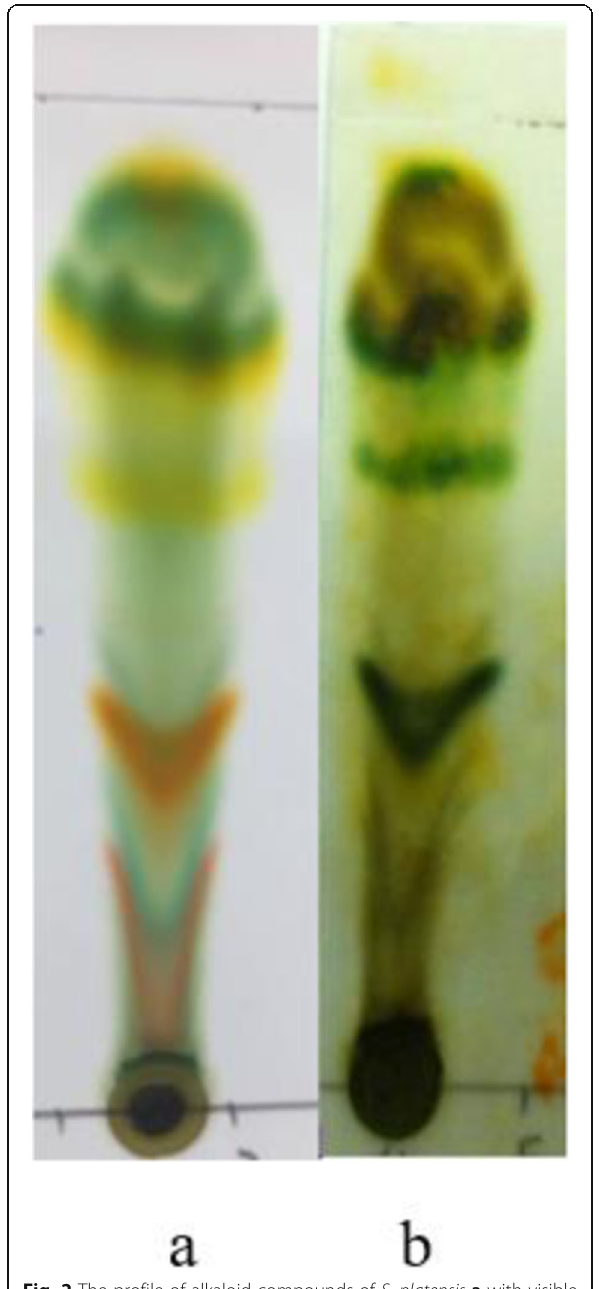
Fig. 2 The profile of alkaloid compounds of S. platensis a with visible light treatment, before sprayed with Dragendorff ’ s reagent b and after sprayed with Dragendorff ’ s reagent